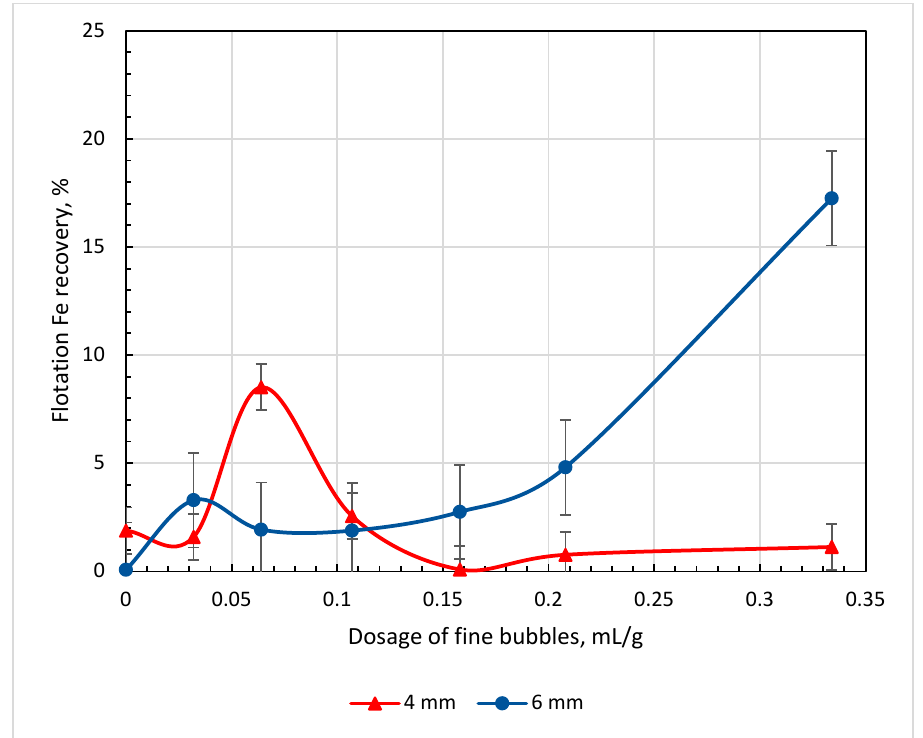
Figure 14. Dependence of the share of the flotation recovery of iron in tailings (froth product) on the fine bubble dosage after treatment in TFRs having 4 and 6 mm inner diameters. CTAB dosage—20 g/t, fine bubble dosage—0.21 mL/g.